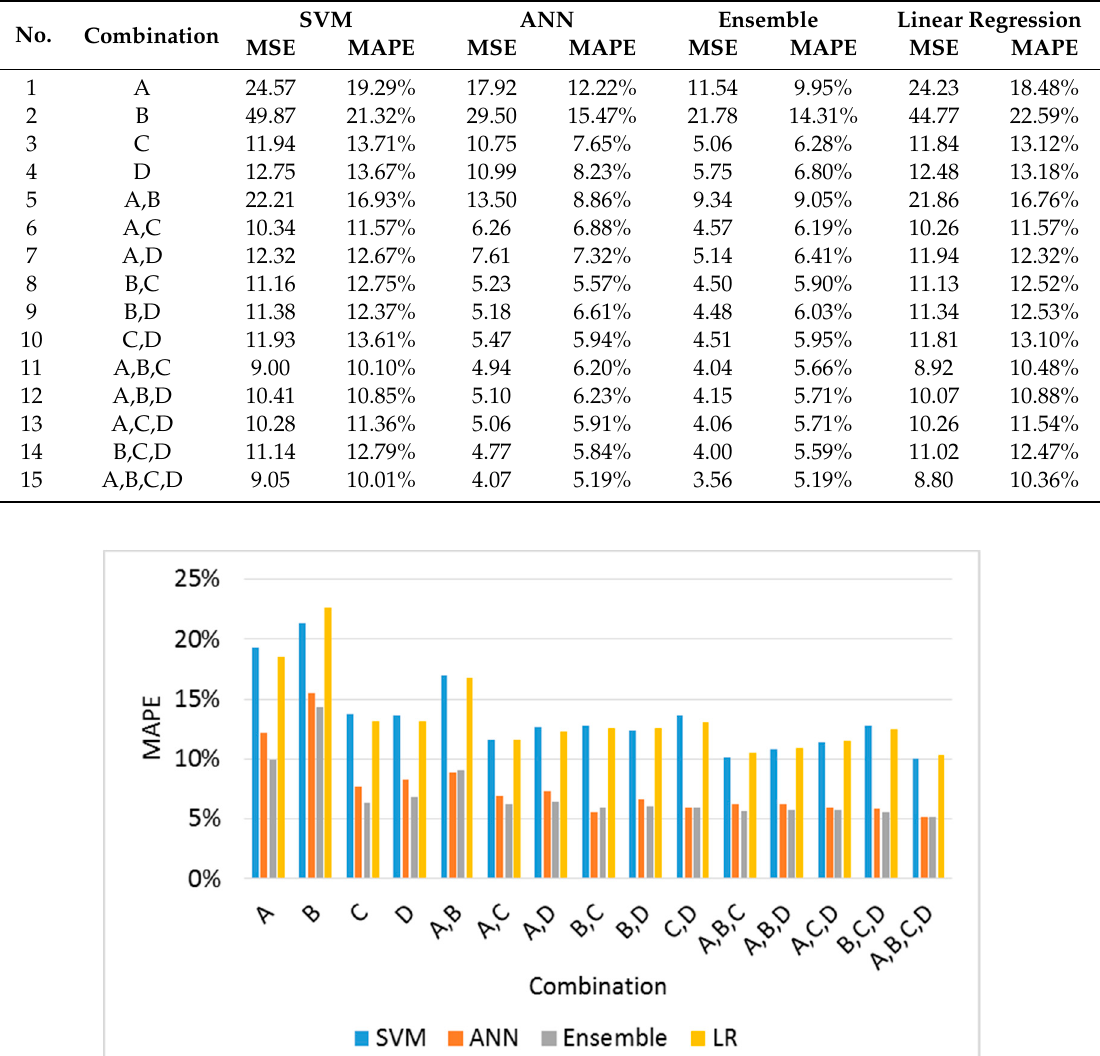
Table 10. Predicted fc results for 15 combination sets using the four ML methods.